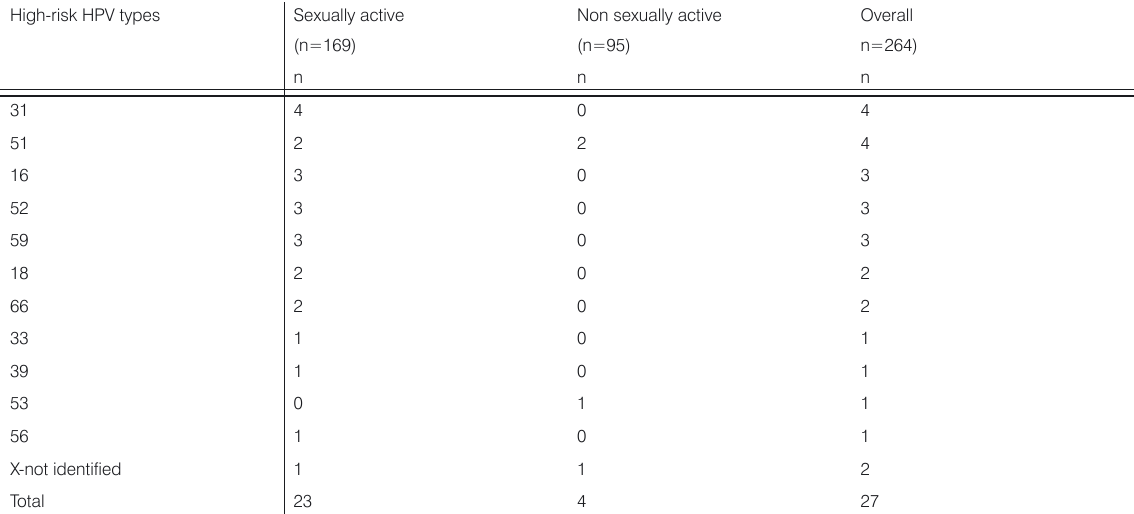
Table 1. Single high-risk HPV infection in sexually active and non active subjects.